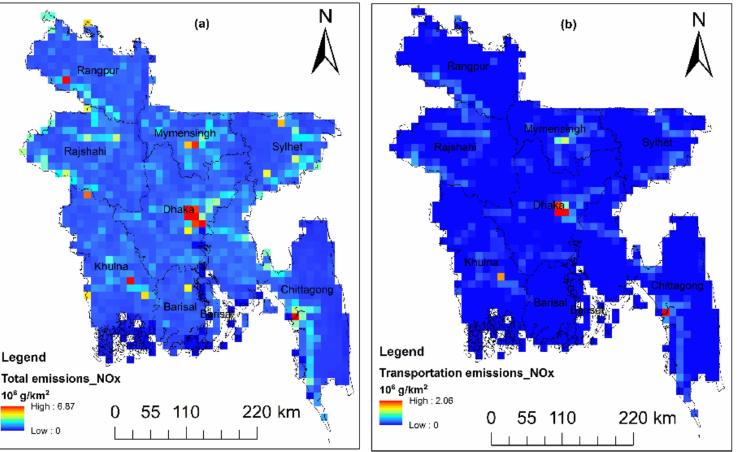
Figure 12. Emission inventory of NO x over the target study area: ( a ) total emissions, ( b ) transportation